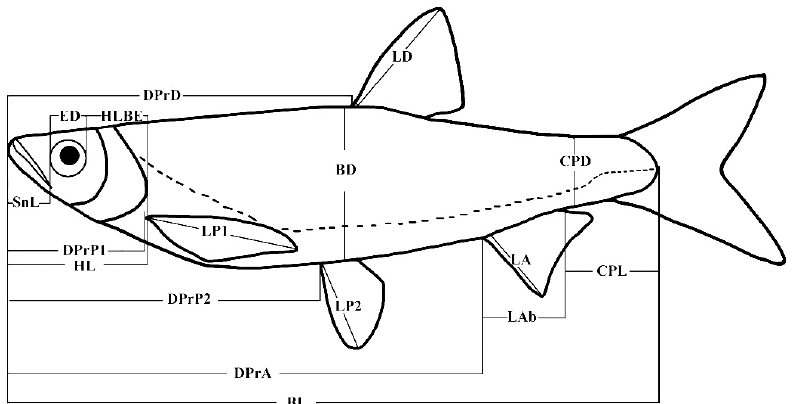
Figure 4. Morphometric parameters investigated for H. leucisculus and H. bleekeri. BL, Body length;